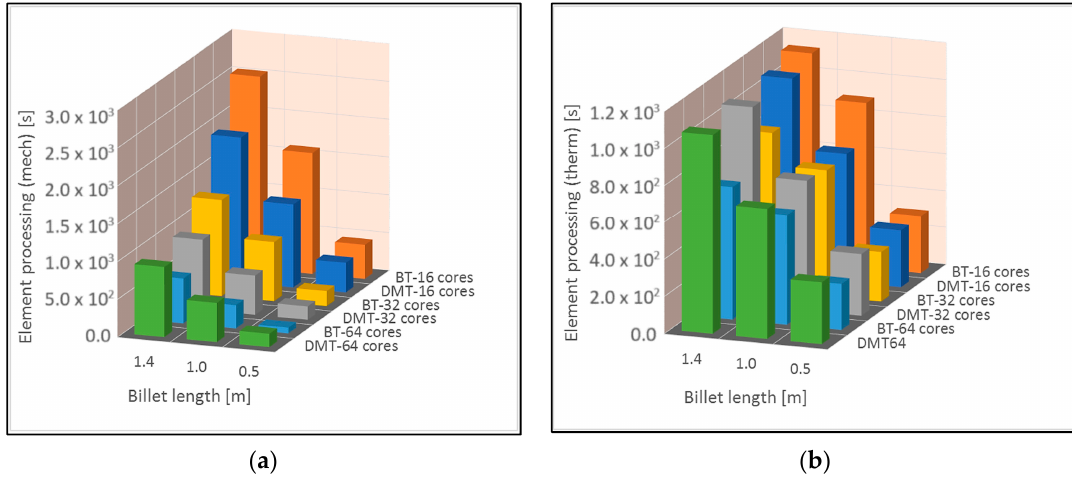
Figure 9. Comparison of element processing time for; ( a ) mechanical; and ( b ) thermal solvers over billet length between DMT and BT for all three billet length scenarios.